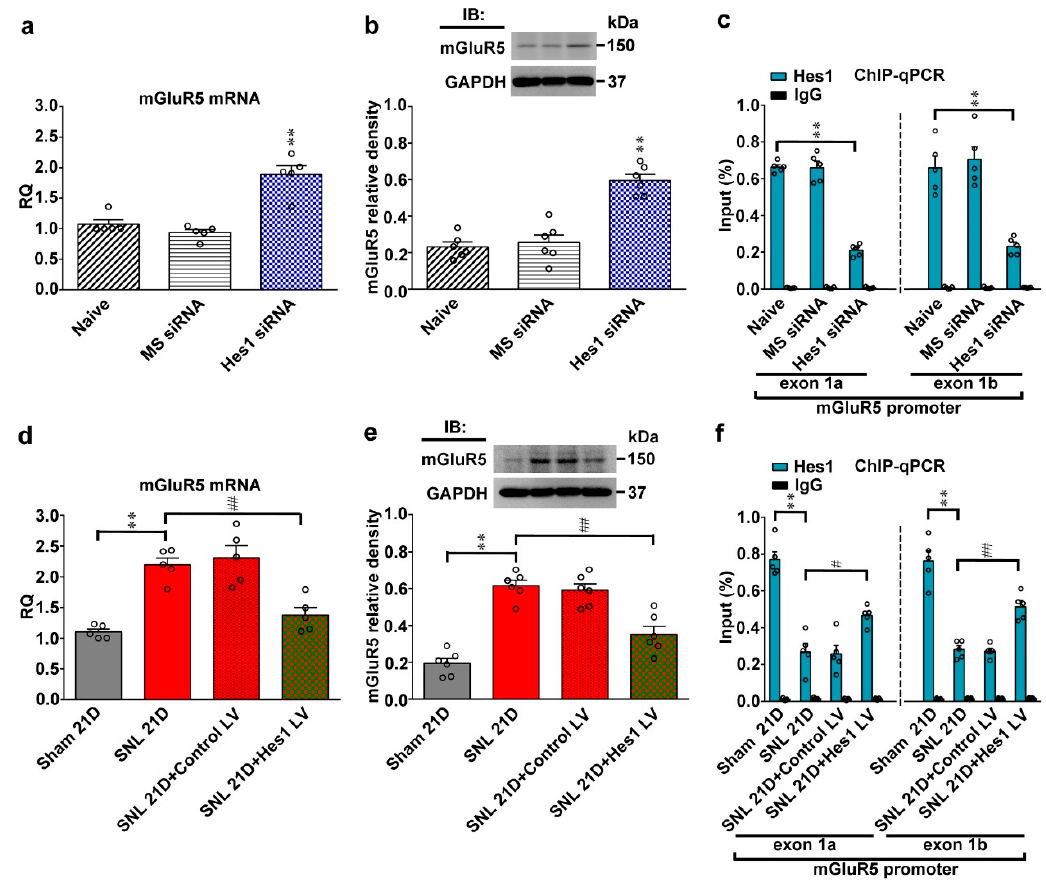
Figure 4. Neuropathic injury diminishes Hes1-repressed spinal mGluR5 transcription. ( a , b ) RT-PCR and western blot analyses (normalized to GAPDH) demonstrating that the mRNA and protein levels of mGluR5 in dorsal horn samples were increased by administering naïve animals (Naive) with Hes1 siRNA but not with missense siRNA (Hes1 siRNA and MS siRNA, respectively. 5 µ g, 10 µ L; it, daily for 4 days). IB, immunoblotting. mRNA, one-way ANOVA, post-hoc Tukey test, F (2,12) = 27.91, p < 0.0001. protein, one-way ANOVA, post-hoc Tukey test, F (2,15) = 34.80, p < 0.0001. ** p < 0.01 vs. Naïve. mRNA, n = 5. protein, n = 6. ( c ) ChIP-qPCR assay of dorsal horn samples demonstrating that administering naïve animals with Hes1 siRNA but not with missense siRNA (Hes1 siRNA and MS siRNA, respectively. 5 µ g, 10 µ L; it, daily for 4 days) decreased amounts of Hes1 antibody-precipitated exon 1a and exon 1b promoter fragments of mGluR5. ** p < 0.01 vs. Naïve. n = 5. Hes1, exon 1a, one-way ANOVA,